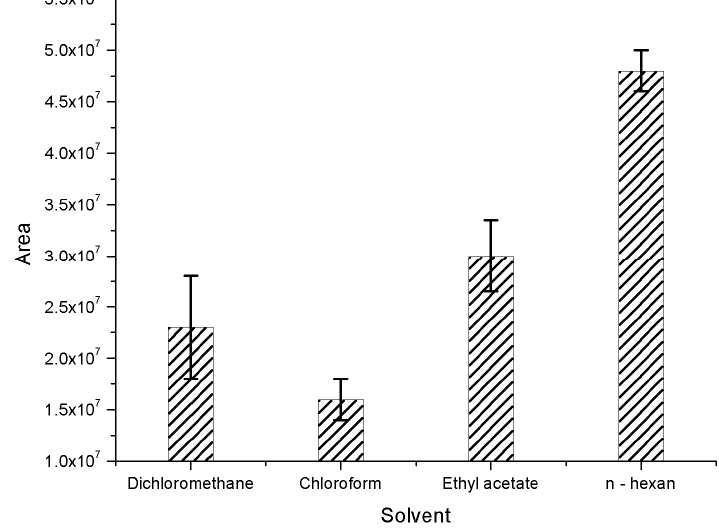
Figure 2. Total peak area of 3 isotope internal standards when using different solvents.